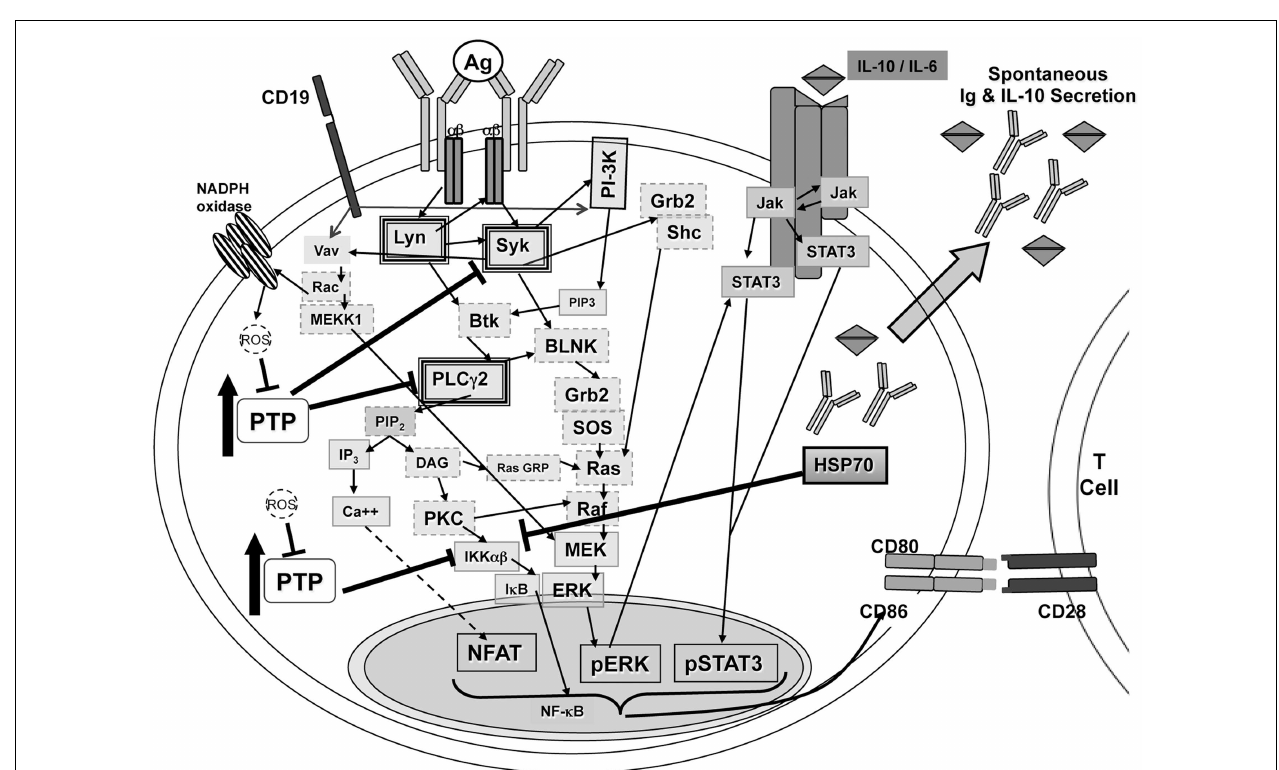
shown to control phosphorylation of Syk and PLC γ 2 differentially in B-1a cells as compared to B2 cells (51). In addition, inhibition of